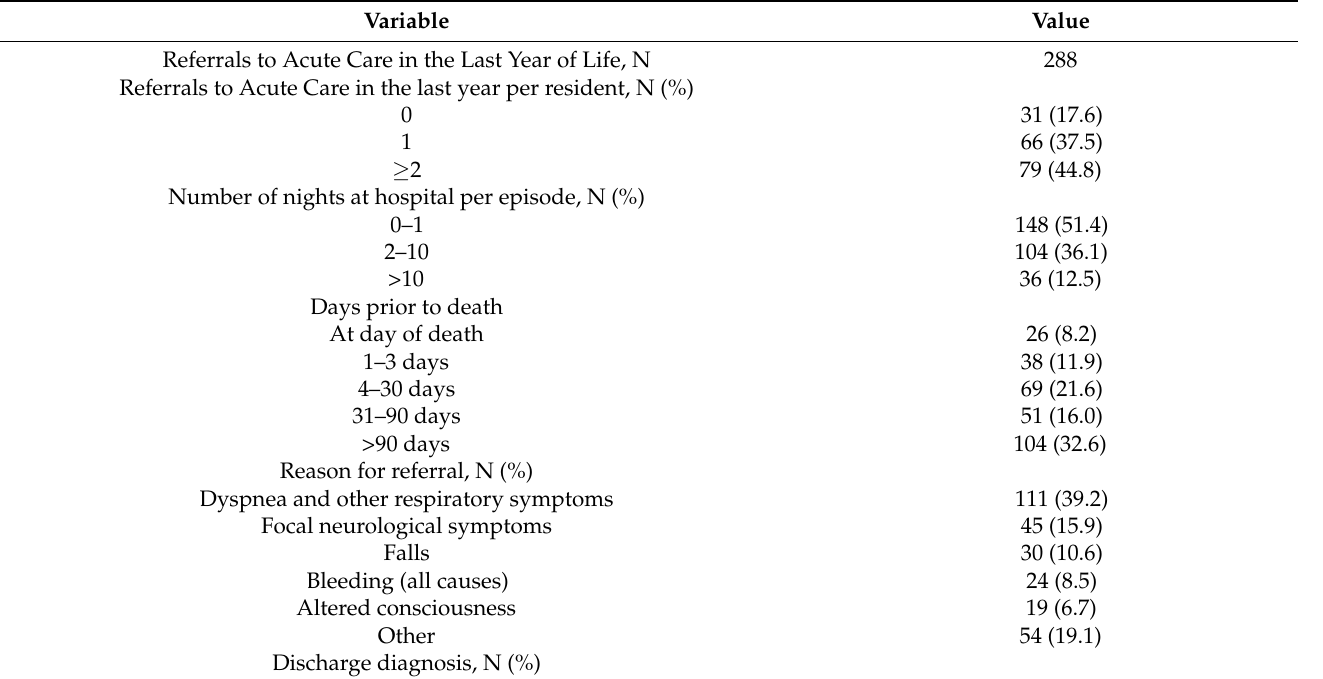
Table 2. Hospitalization in the last year of life.